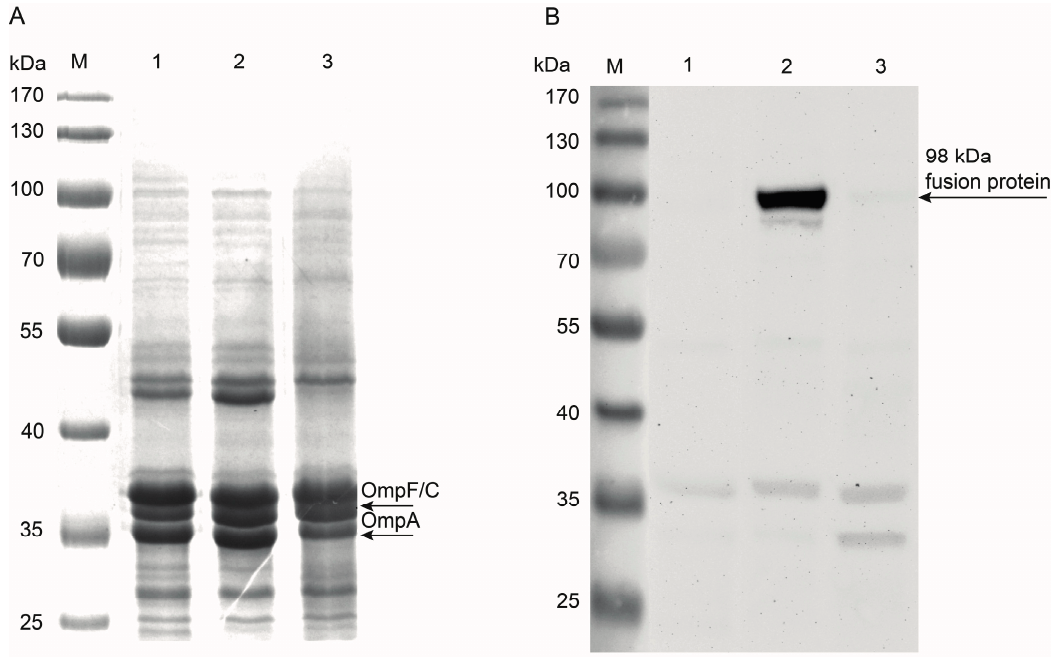
Figure 3. Surface exposure of Hyal-1 on E. coli F470. M: PageRuler Prestained Protein Ladder (Fermentas); Lane 1: E. coli F470 without plasmid (control sample); Lane 2: E. coli F470 + pAK009; Lane 3: E. coli F470 + pAK009 with whole cell digestion using proteinase K before membrane protein preparation. ( A ) Coomassie stained SDS-PAGE of enriched outer membrane protein from E. coli F470. Samples were dissolved in denaturation buffer containing 2% SDS and 100 mM dithiothreitol (DTT) (final concentration) and heated for 10 min at 95 °C; ( B ) Antigenic evaluation of enriched outer membrane proteins from E. coli F470 after SDS-PAGE with 10% PA and western blot. For detection, polyclonal